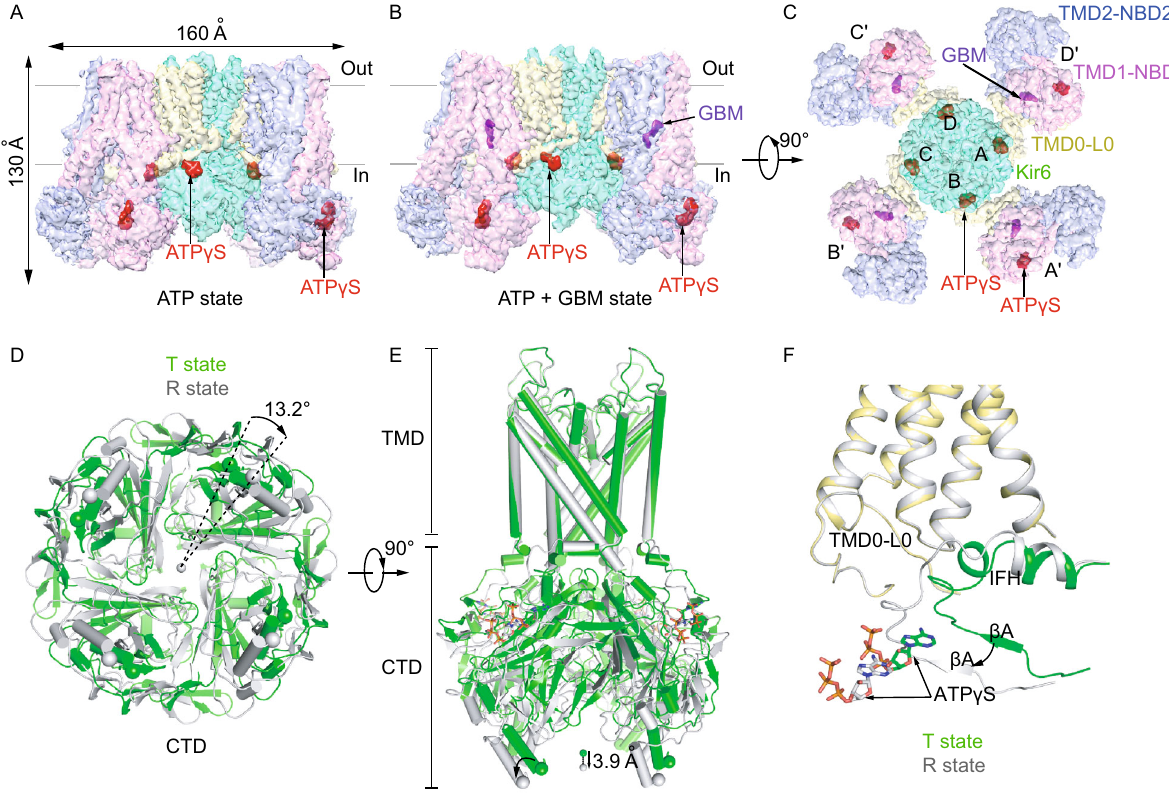
Figure 1. Structures of the pancreatic K ATP channel in complex with ATP γ S or ATP γ S and glibenclamide (GBM). (A) Side view of the K ATP channel in complex with ATP γ S (ATP state). Approximate extent of the phospholipid bilayer is shown as thick gray lines. Kir6.2, SUR1 TMD0-L0 (transmembrane domain 0-loop 0) fragment, TMD1-NBD1 (nucleotide binding domain1), TMD2-NBD2, ATP γ S and GBM are shown in green, yellow, magenta, blue, red and purple, respectively. (B) Side view of the K ATP channel in complex with ATP γ S and GBM (ATP + GBM state), colored the same as in (A). (C) Bottom view of the K ATP channel in complex with ATP γ S and GBM from the intracellular side. (D) Bottom view of the aligned Kir6.2 structures between “ Tstate ” (green) and “ R state ” (gray) of the ATP + GBM state. Rotation angle between CTDs (cytoplasmic domain) was measured using C α positions of L356 of Kir6.2, shown as spheres. (E) Side view of the aligned Kir6.2 structures between “ T state ” (green) and “ R state ” (gray) of the ATP + GBM state. Vertical movement of CTDs is measured between the centers of mass of L356 C α s. (F) Positional difference of Kir6.2 β A and IFH (interfacial helix) between “ T state ” and “ R state ” structures of the ATP +